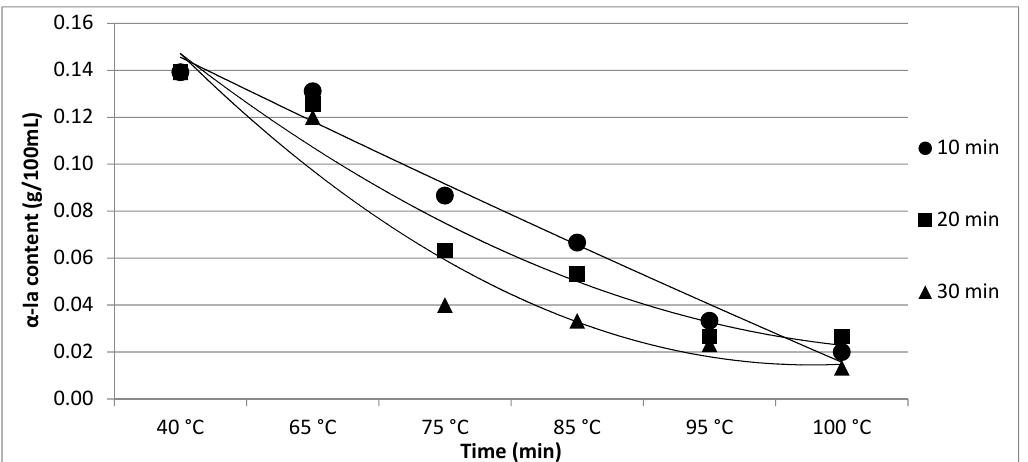
Figure 5. Effect of heating time and temperature on α -la content. Equations: 10 min (y = 0.0003x 2 – 0.0283x + 0.1735; R 2 = 0.9753), 20 min (y = 0.0038x 2 − 0.0512x + 0.1946; R 2 = 0.9497), 30 min (y = 0.0058x 2 − 0.0672x + 0.2085; R 2 = 0.9323).